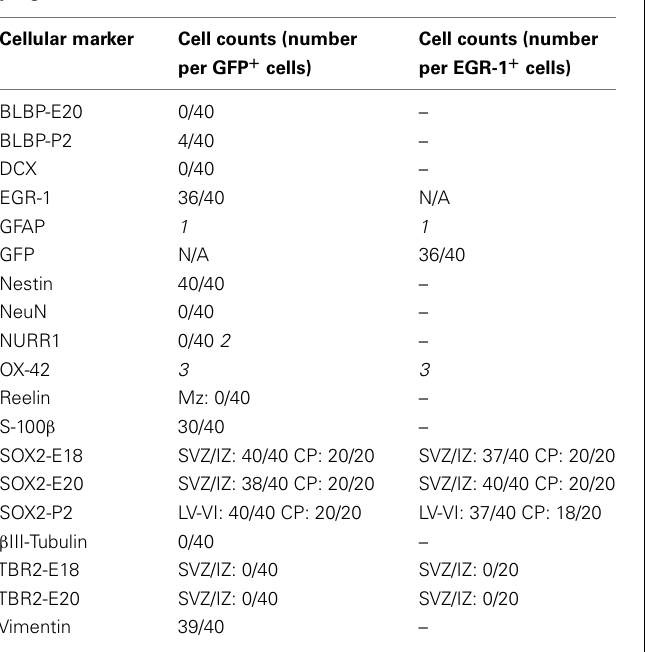
Table 2 | Quantitative analysis of protein co-localization in SOX2 + progenitor cells.